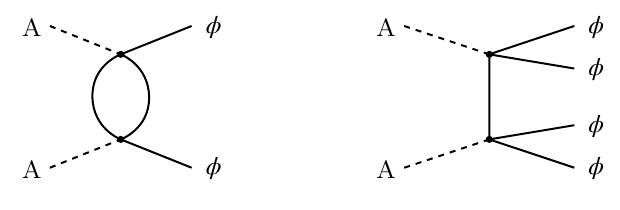
Figure 4 . The two types of diagrams that contributes to the rate AA ! CFT in the free scalar theory with O = (cid:30) 2 , with (cid:12)nal states corresponding to the primary operator (cid:30) 2 (left), (cid:30) 4 (right), or their